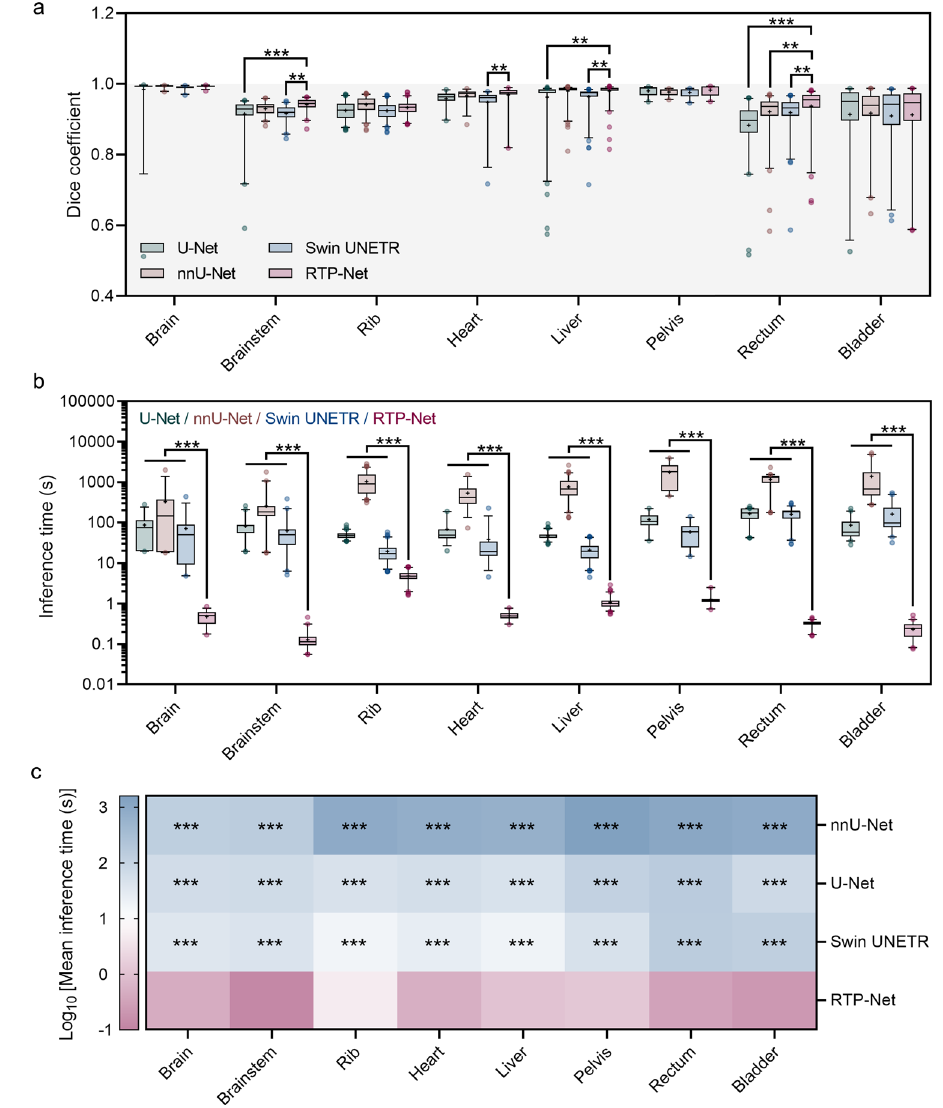
Fig.5|Quantitativecomparisonofsegmentationperformanceoffourmethods in terms of Dice coef fi cient and inference time. a Dice coef fi cients of eight seg- mentation tasks by our proposed RTP-Net, U-Net, nnU-Net, and Swin UNETR. b Mean inference times in segmenting eight OARs by four methods. Both Dice coef fi cients ( a ) and inference times ( b ) are shown in box-and-whisker plots. The fi rst quartile forms the bottom and the third quartile forms the top of the box, in which the line and the plus sign represent the median and the mean values, respectively. The whiskers range from 2.5 th to 97.5 th percentile, and points below and above the whiskers are drawn as individual dots. The number of eight organs can be referred to Supplementary Fig. 1. Statistical analyses in ( a ) and ( b ) are performed using two-way ANOVA followed by Dunnett ’ s multiple comparisons tests. Asterisk represents two-tailed adjusted p value, with * indicating p <0.05, ** indicating p <0.01, and ***indicating p <0.001. The p values of Dice coef fi cients in